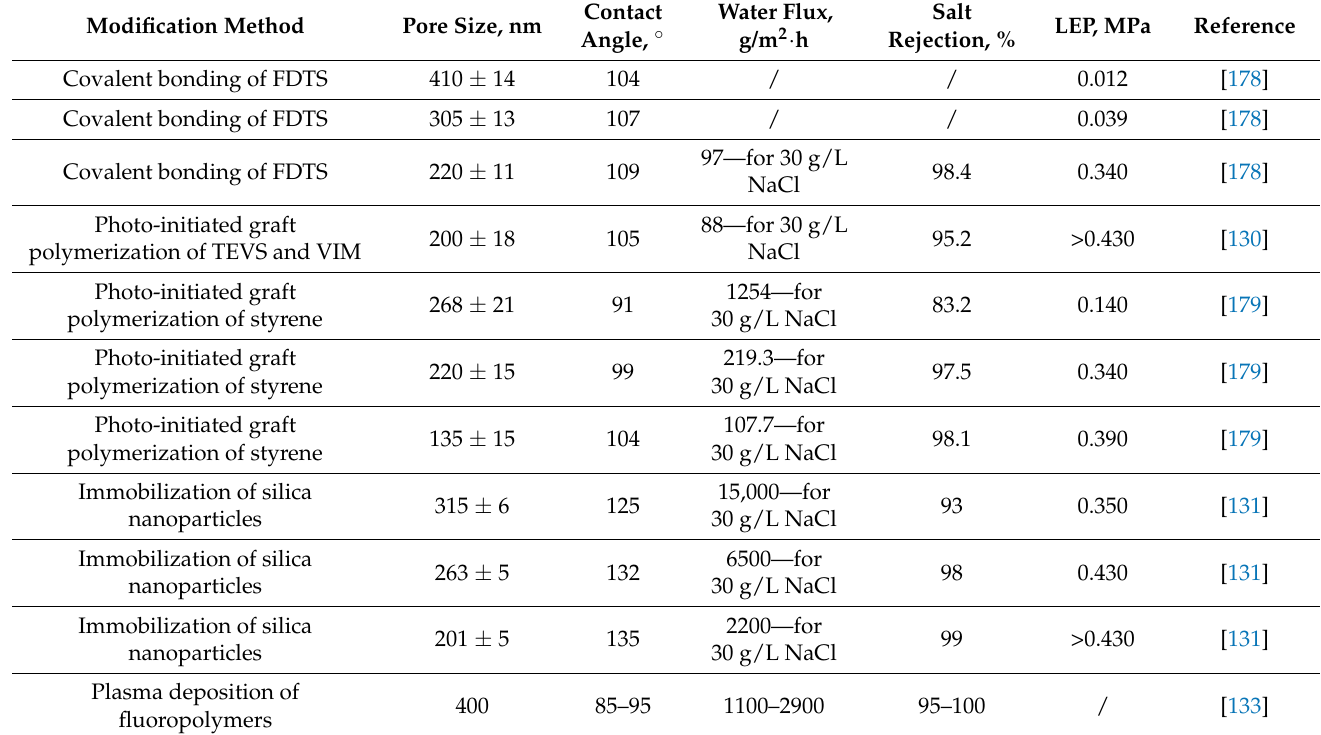
Table 6. Dependence of the LEP values and the contact angle on the pore size of the PET TeMs modified with different methods and their performance in MD process. Modification